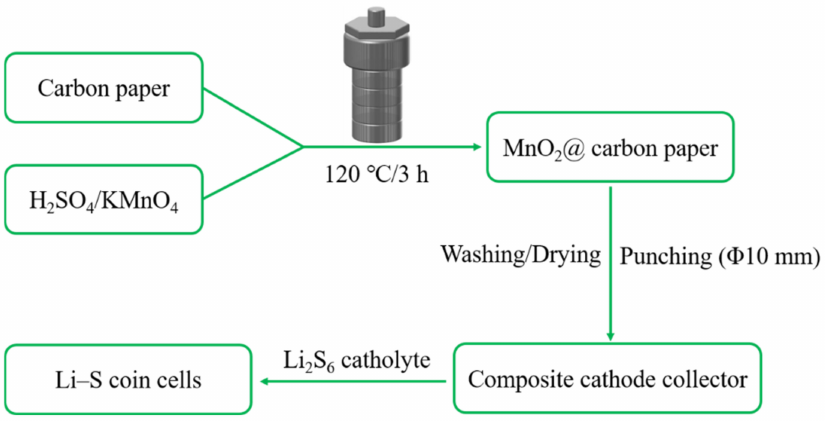
Figure 1. Schematic illustration of preparing the composite cathode collector and Li–S